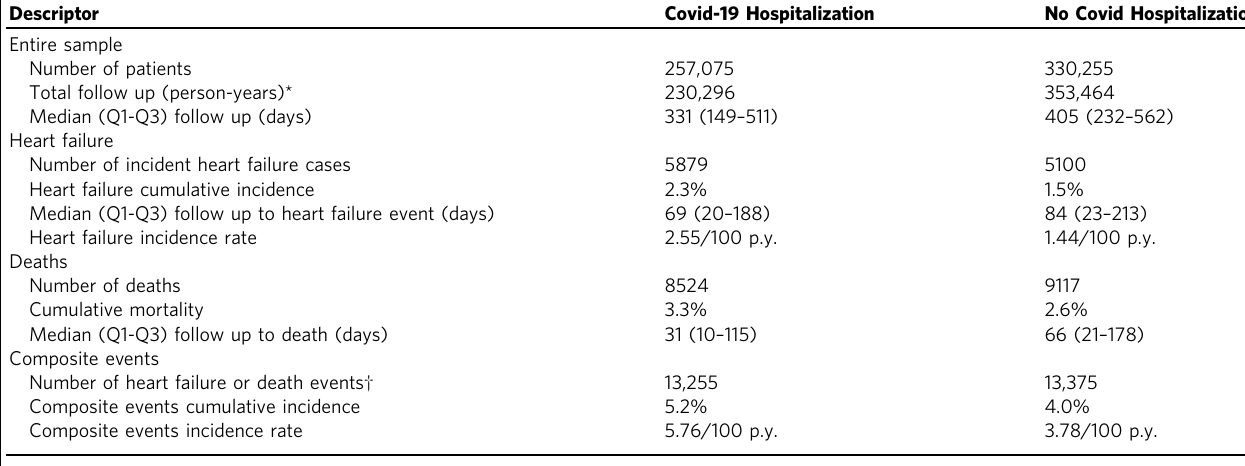
Table 2 Summary of post-hospitalization follow up and events among patients with and without COVID-19